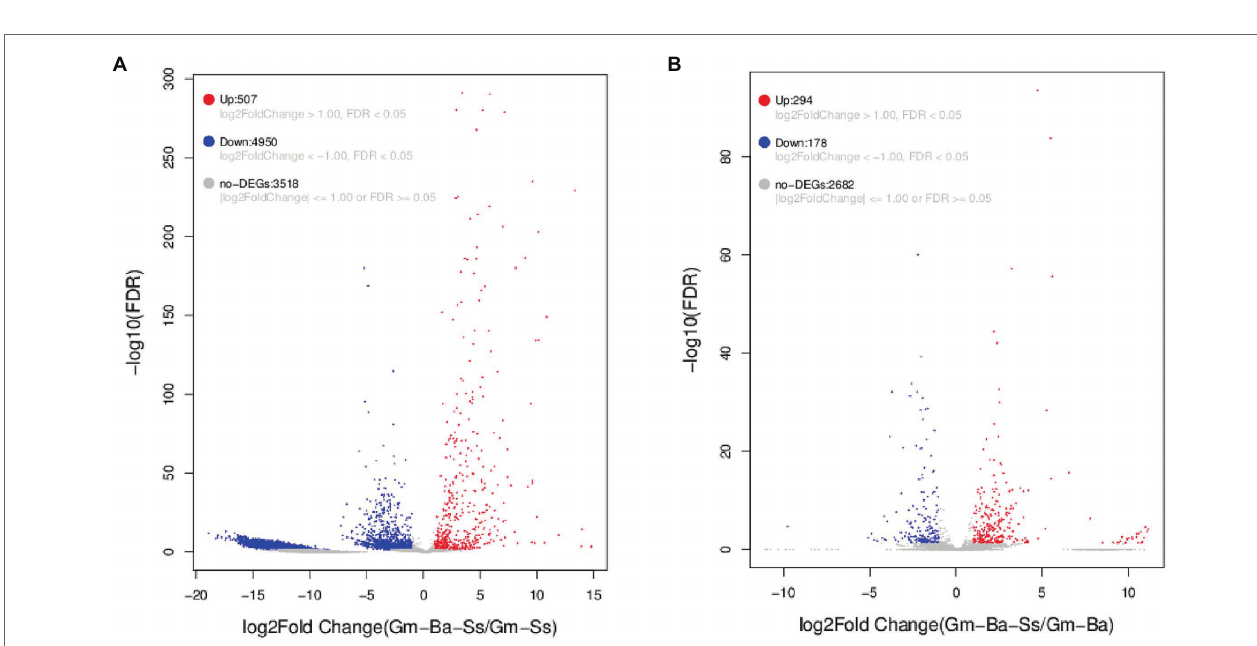
FIGURE 4 | Box plot of transcript expression. (A) Box plot of S. sclerotiorum transcript expression in treatments of Ss and Ba-Ss. (B) Box plot of B. amyloliquefaciens transcript expression in treatments of Ba and Ba-Ss. Gm-Ba, Gm-Ss, Gm-Ba-Ss indicated that the Glycine max seedling were inoculated with B. amyloliquefaciens , S. sclerotiorum and their mixture, respectively.